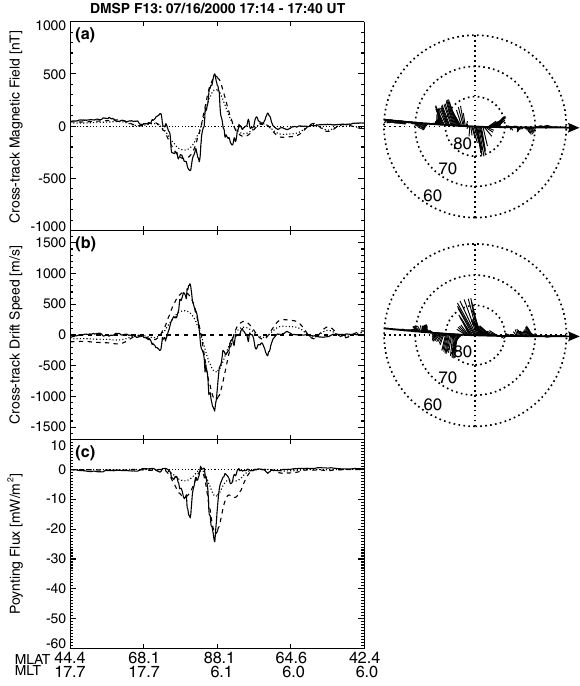
Fig. 6. Comparison of ( a ) the cross-track magnetic perturbation, ( b ) the drift speed, and ( c ) the radial Poynting vector measured by DMSP F15 (solid lines) with calculations using both the unscaled (dotted lines) and scaled (dashed lines) Iridium fit along the DMSP F15 trajectory. The polar plots show the respective vector quantities in AACGM MLT-MLAT coordinates.